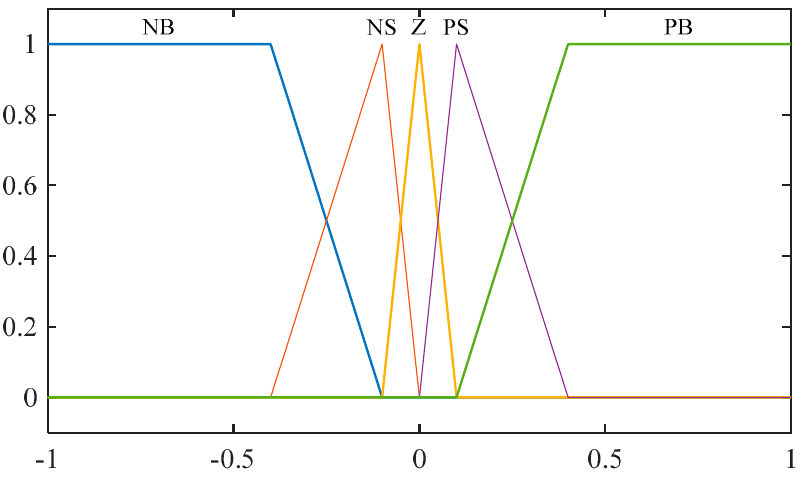
Figure 3. The membership functions of the proposed fuzzy design.